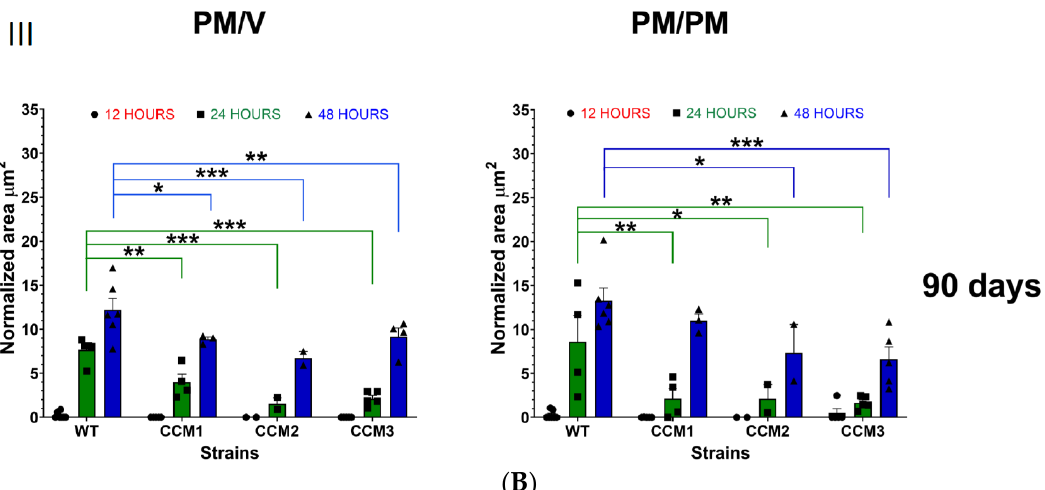
Figure 4. Overall ex vivo angiogenic performance of nPR( − ) ECs derived from dorsal aortae of Ccms mice under mPR ‐ specific PRG actions. After euthanizing, dorsal aortae were immediately removed from Ccm 1 +/ − , Ccm2 +/ − , and Ccm3 +/ − hemizygous mutant and WT (C57 BL/6 J) mice treated for 30, 60, or 90 days and were divided in half and placed in matrigel media supplemented with vehicle (V, DMSO + EtOH left panels) or mPR ‐ specific PRG treatment (PM, progesterone + mifepristone, 20 μ M each, right panels). Images were acquired in 2 h intervals on a Nikon Biostation CT for 72 h. After